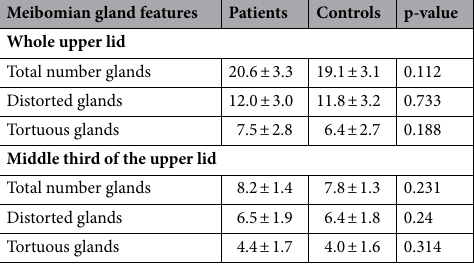
Table 2. Frequency of upper lid meibomian gland